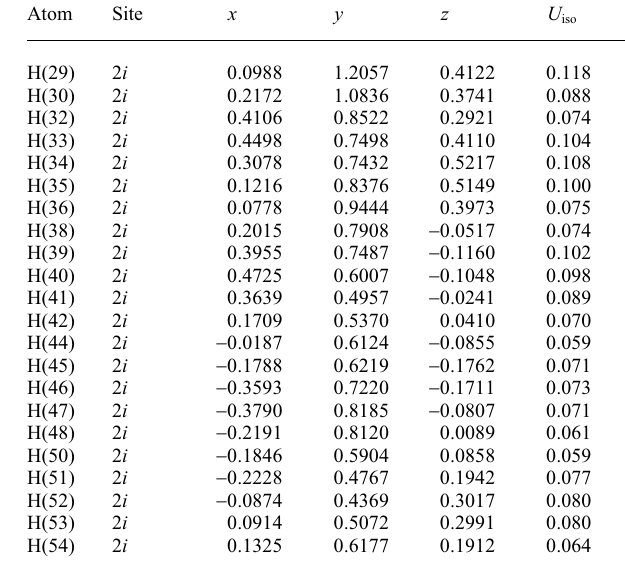
Table 2. Atomic coordinates and displacement parameters (in Å 2 ) . Atom